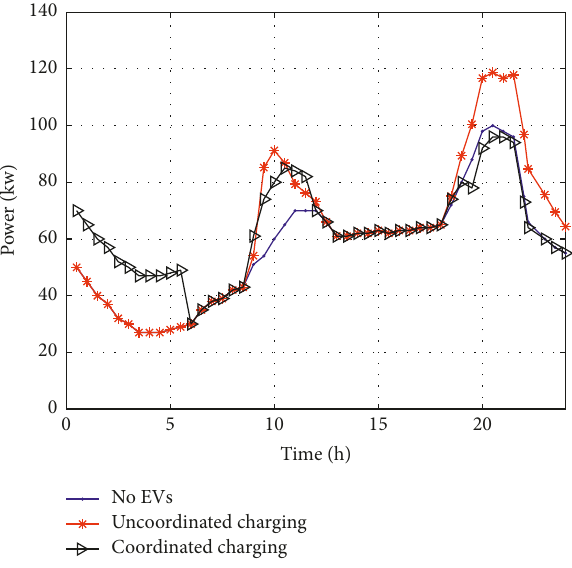
Figure 7: Simulation result of one branch.